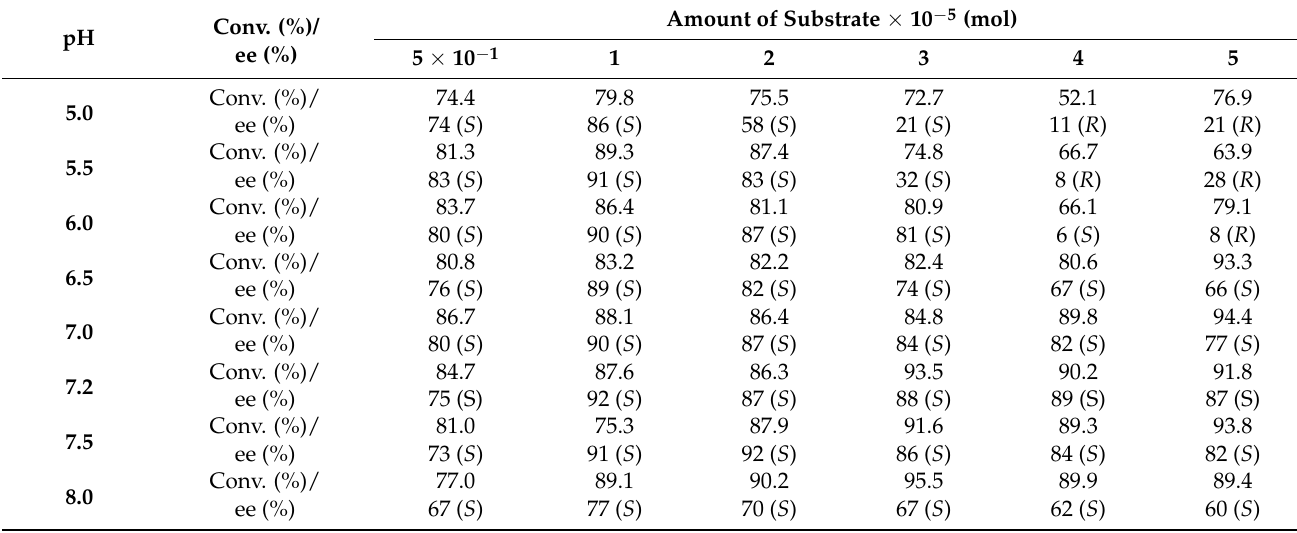
Table 1. Microbial Bioreduction of Benzil ( 1 ) to ( S )-2-Hydroxy-1,2-Diphenylethanone ( 2 ) in Phosphate Buffer at Different pH Values and Various Concentrations of 1 .